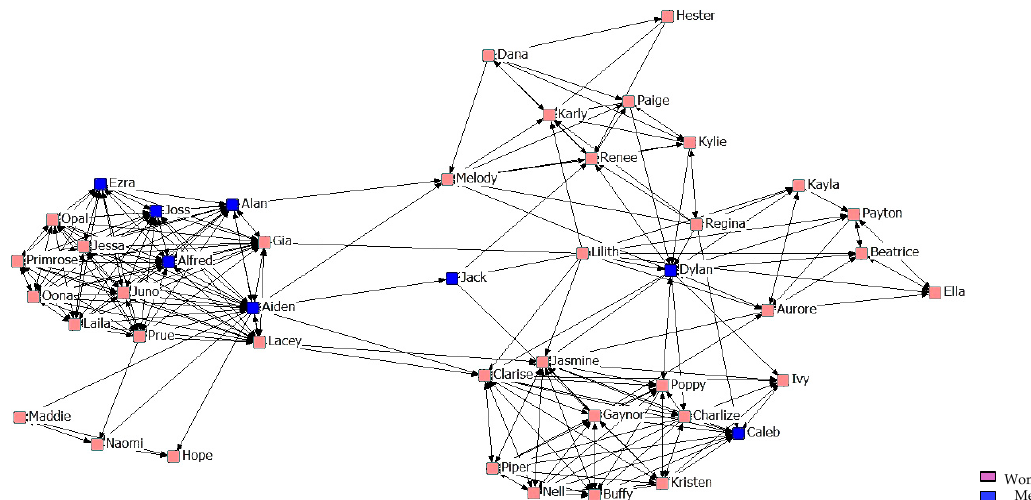
Figure 9. Graph of the second year Maximum Friendship Network.